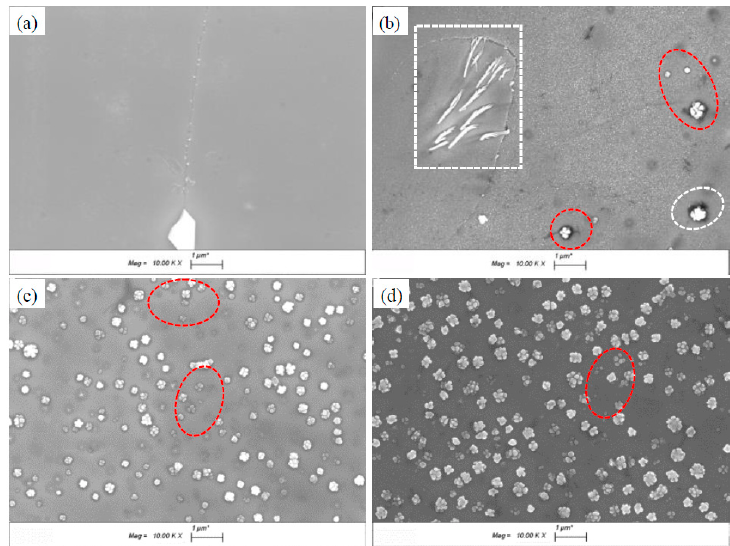
Figure 5. The evolution of the γ′ precipitates during interrupt cooling at the cooling rate of 1 °C/min: ( a ) 1010 °C, ( b ) 1000 °C, ( c ) 990 °C, ( d ) 980 °C.